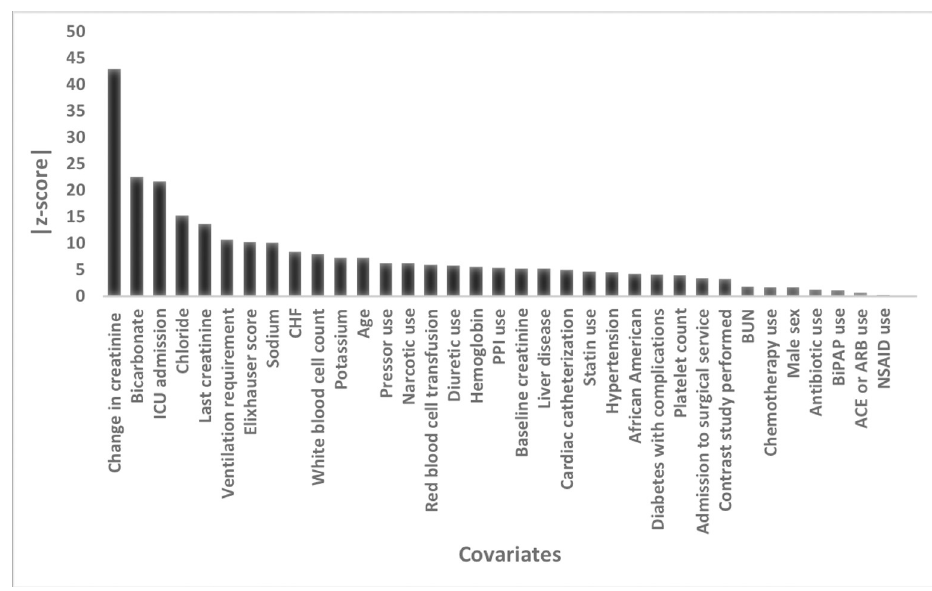
Fig 2. Performance of model covariates within the fully adjusted model. Higher absolute value of Wald z-scores indicate a greater degree of statistical significance within the predictive model.